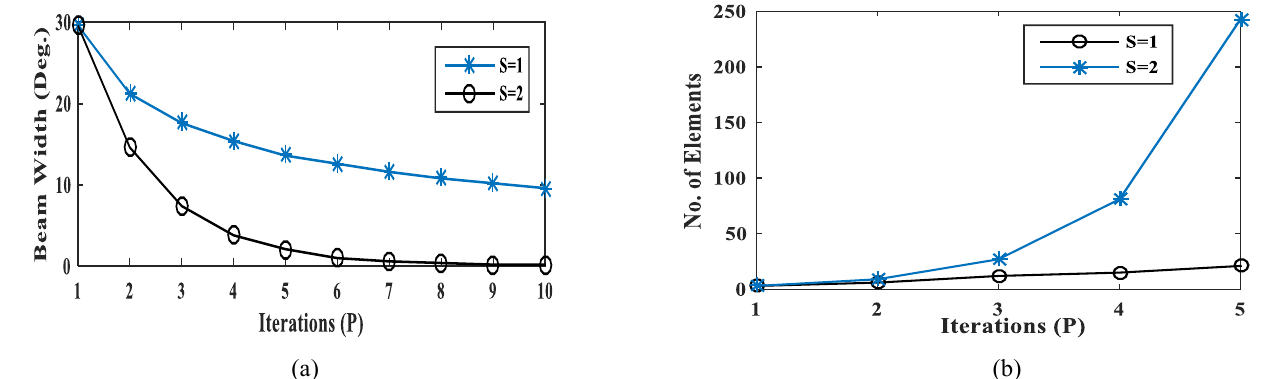
Figure.9 . (a) Number of iterations with corresponding beam widths and (b) Number of iterations with number of elements. Table .I. Comparison of SLL, HPBW, SLL Angle of both linear fractal arrays generated with concentric elliptical and circular sub array generators for expansion factors S=1 and 2 up to four iterations .